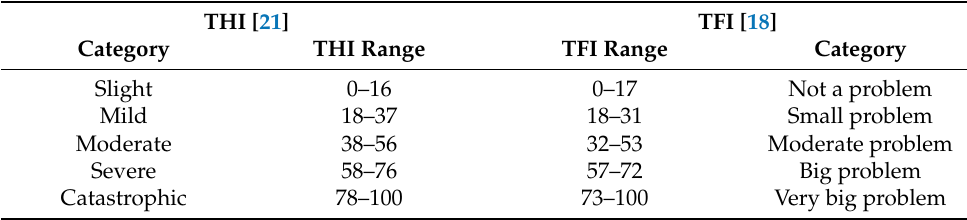
Table 2. Categories of